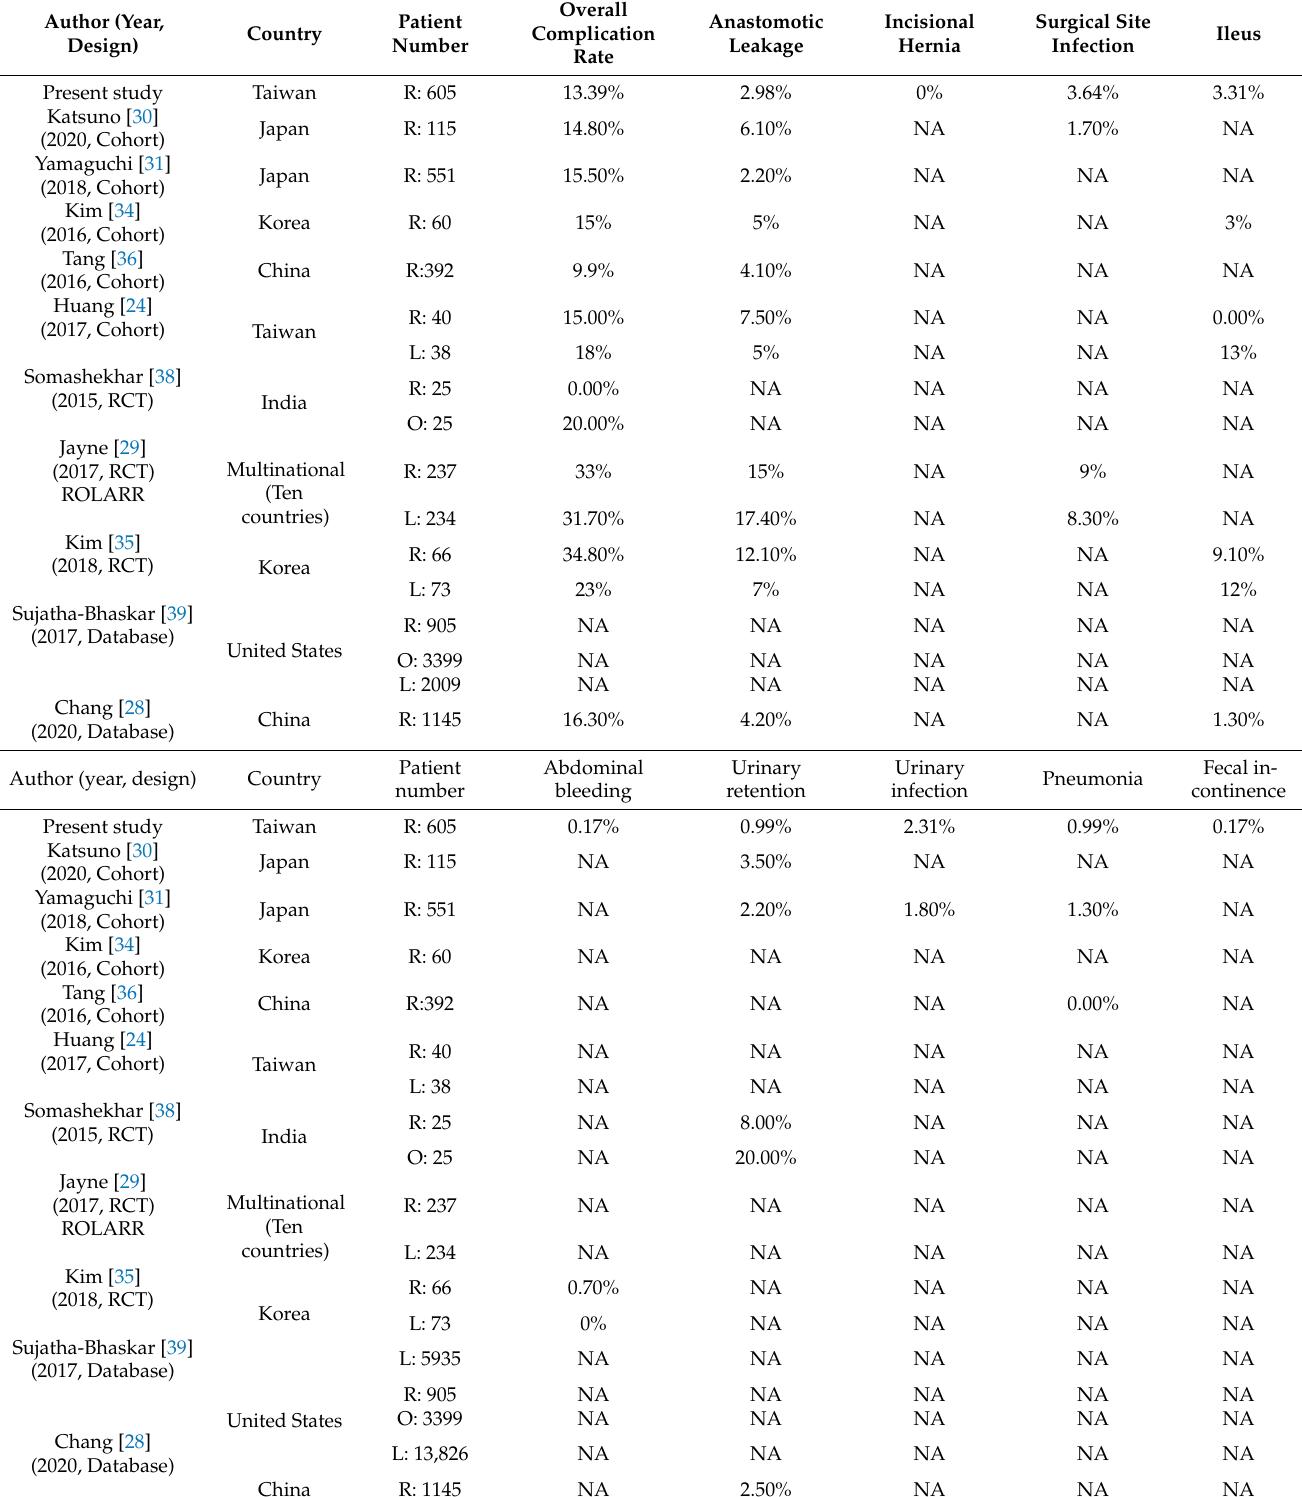
Table 5. Complication characteristics of studies from relevant